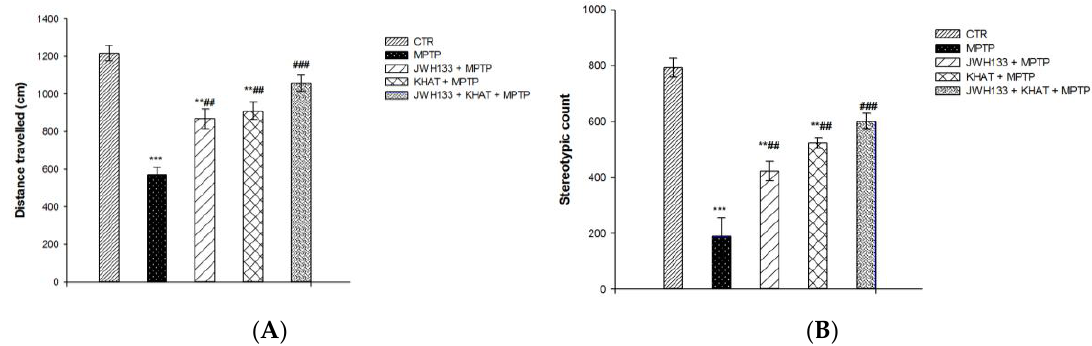
Figure 4. Effect of sub-acute administration of khat extract alone and in combination with JWH133 on MPTP induced motor deficits. ( A ) Effect of sub-acute administration of khat extract alone and in combination with JWH133 on distance travelled in MPTP mouse model. ( B ) Effect of sub-acute administration of khat extract alone and in combination with JWH133 on stereotypic count in MPTP mouse model. Values are mean ± SEM (n=6 in each group). Statistical analysis was done using one-